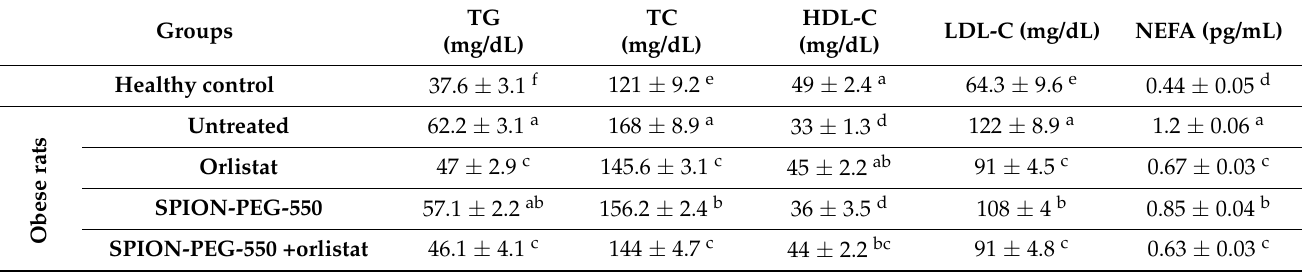
Table 5. Statistical analysis of lipid profile parameters and NEFA in the different studied